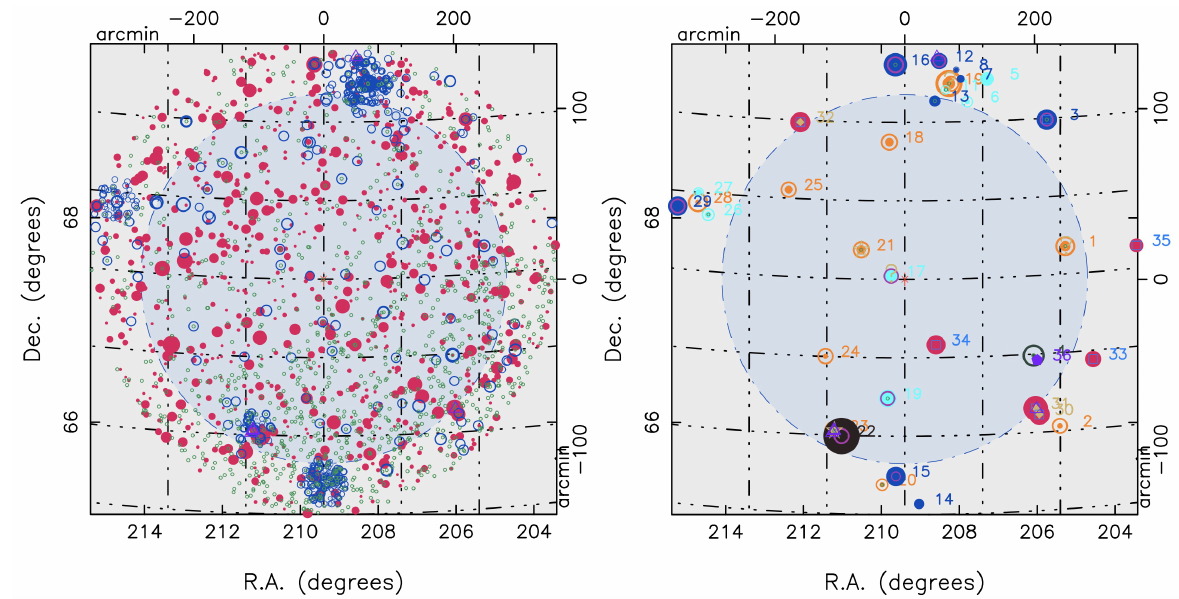
Figure 3. The region around the uncertainty in the arrival direction of the IceCube neutrino IC140216A (light blue elliptical area) as presented by VOU-Blazars. Left: multi-frequency catalogued sources, right: known and candidate blazars. See text for